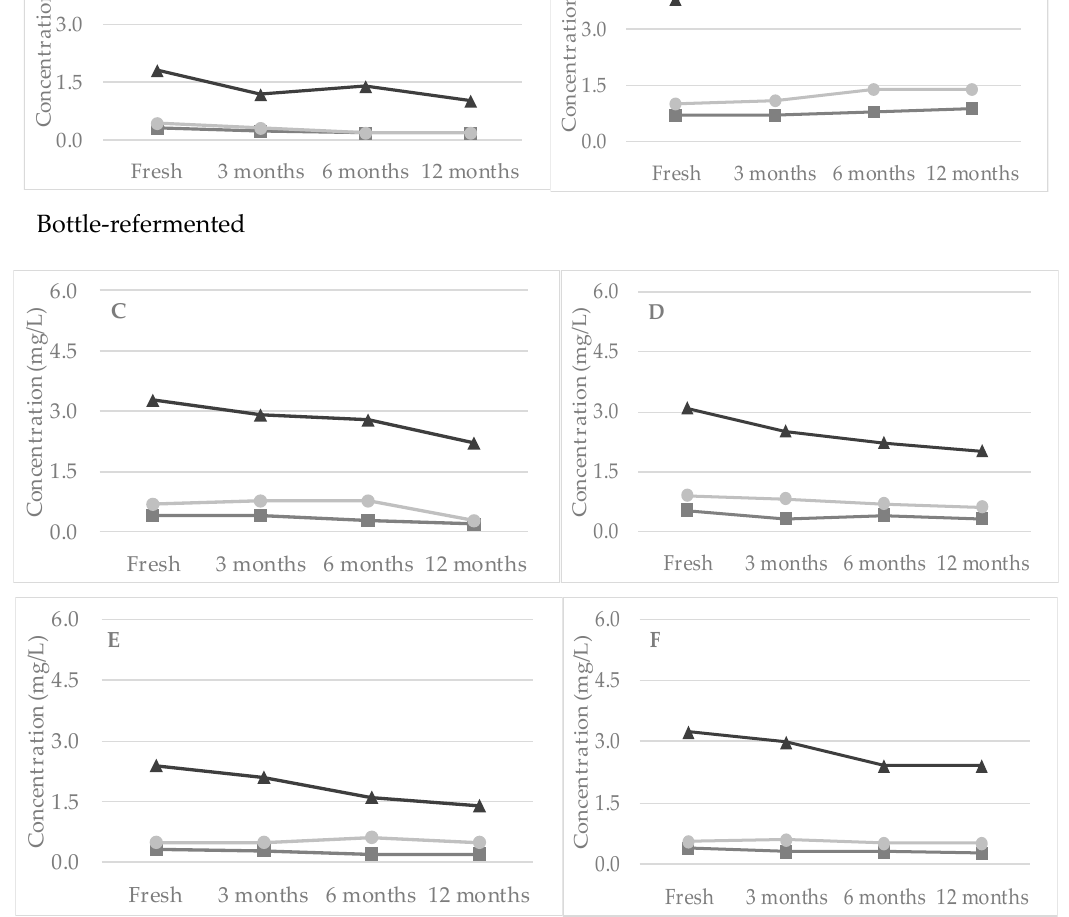
Figure 4. Concentrations (mg/L) of isoamyl acetate ( ▲ ), ethyl hexanoate ( ■ ), and ethyl octanoate ( ● ) in fresh beers (A–F) and their evolution during natural aging (3, 6, and 12 months). Variation coefficients under 5%.